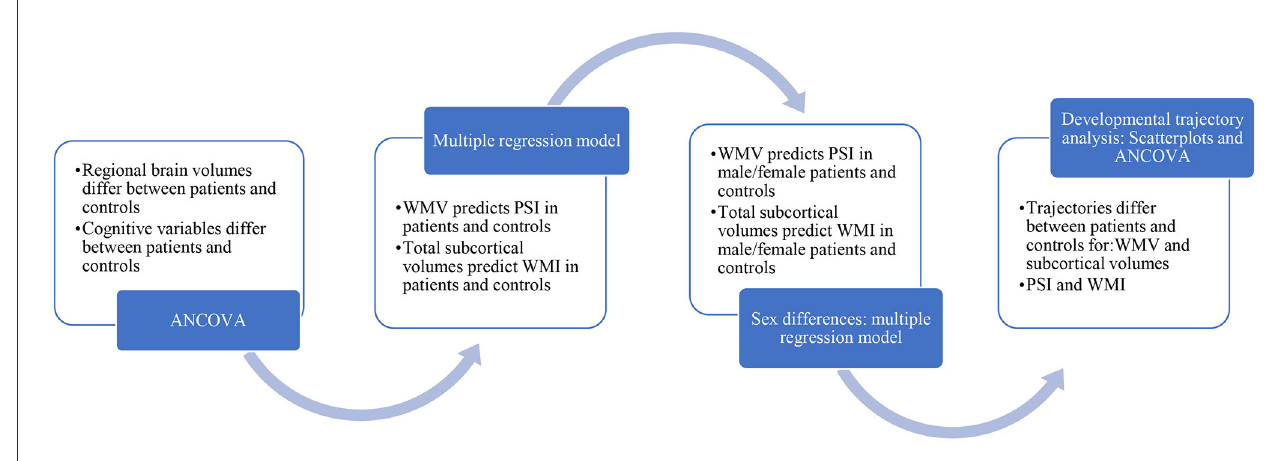
FIGURE1 Statistical